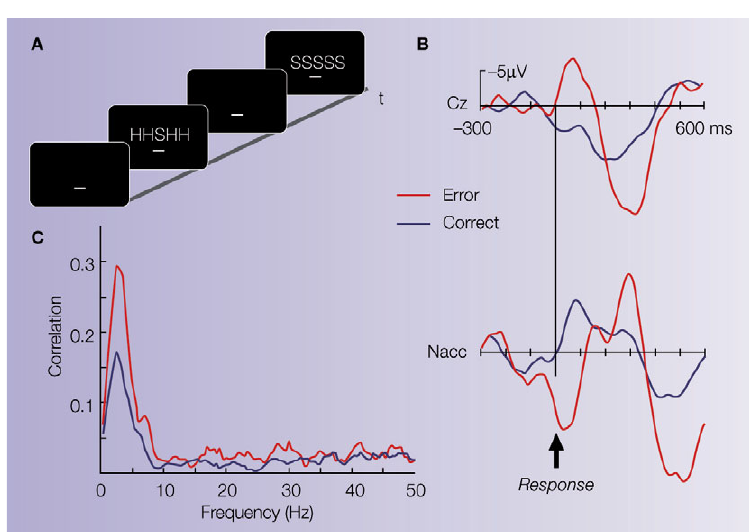
Figure 2 | Illustrative case. (A) The Eriksen fl anker task requires to respond to the center let- ter of a 5-letter array with either a left-hand (for letter H) or right-hand response (letter S). Incongruent trials (either HHSHH or SSHSS) increase the number of errors produced by the participant. (B) Averaged ERP from the electrode site Cz (reference at the right mastoid proc- ess) and averaged LFP activity from the Ncl accumbens (stainless macro-electrode contact, reference: guiding tube of electrode). The surface electrode shows an error related negativity (ERN). Ncl accumbens activity similarly shows an error-related modulation which preceded the surface activity by ∼ 40 ms. (C) Coherence between the contact in the Ncl accumbens and the Cz electrode: Coherence is a measure of the degree to which it is possible to linearly predict change in one signal given a change in another signal (Brillinger, 1981; Halliday et al., 1995). Coherence can take values between 0 and 1, with 0 indicating non-linearly related signals and 1 corresponding to identical signals. A marked coherence was observed with a peak around 3 Hz which was considerably larger for the error